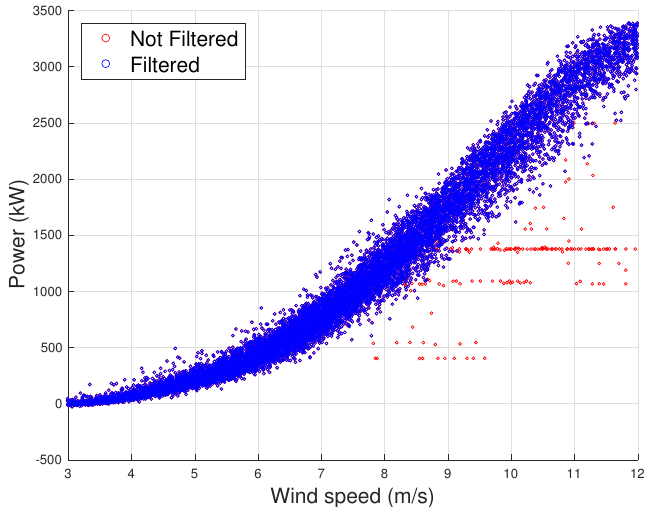
Figure 2. Example of raw and filtered power curve data of